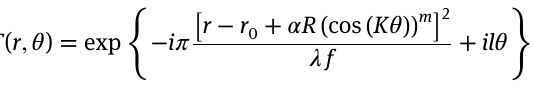
Figure 4A3–4 depict PZPs with annular petal-like zones with K = 5, m = 1, 𝛼 = 0.05, f = 10 mm, r l = 0 and K = 6, m = 1, 𝛼 = 0.05, f = 10 mm, r